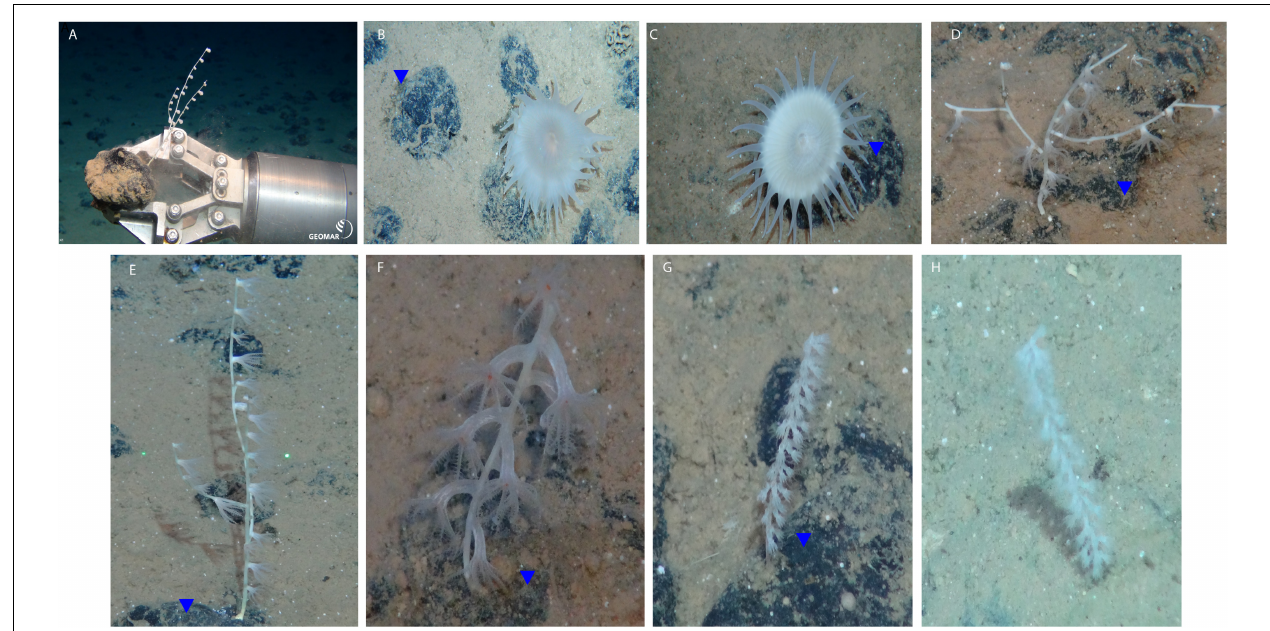
FIGURE 1 | Sample collection and specimens. (A) ROV Kiel 6000 GEOMAR manipulator arm collecting a coral sample attached to a polymetallic nodule. (B,C) Actinostolidae, (D–F) Isididae, (G,H) Calyptrophora sp. (Primnoide). Note that blue triangles point polymetallic nodules. Photo credits: GEOMAR.